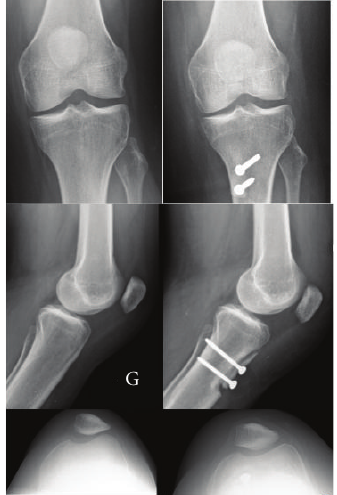
Figure 3: Pre- (left) and postoperative (right) radiograph of the left knee after medial and distal tibial tubercle transfer and vastus medialis plasty. The patella is better